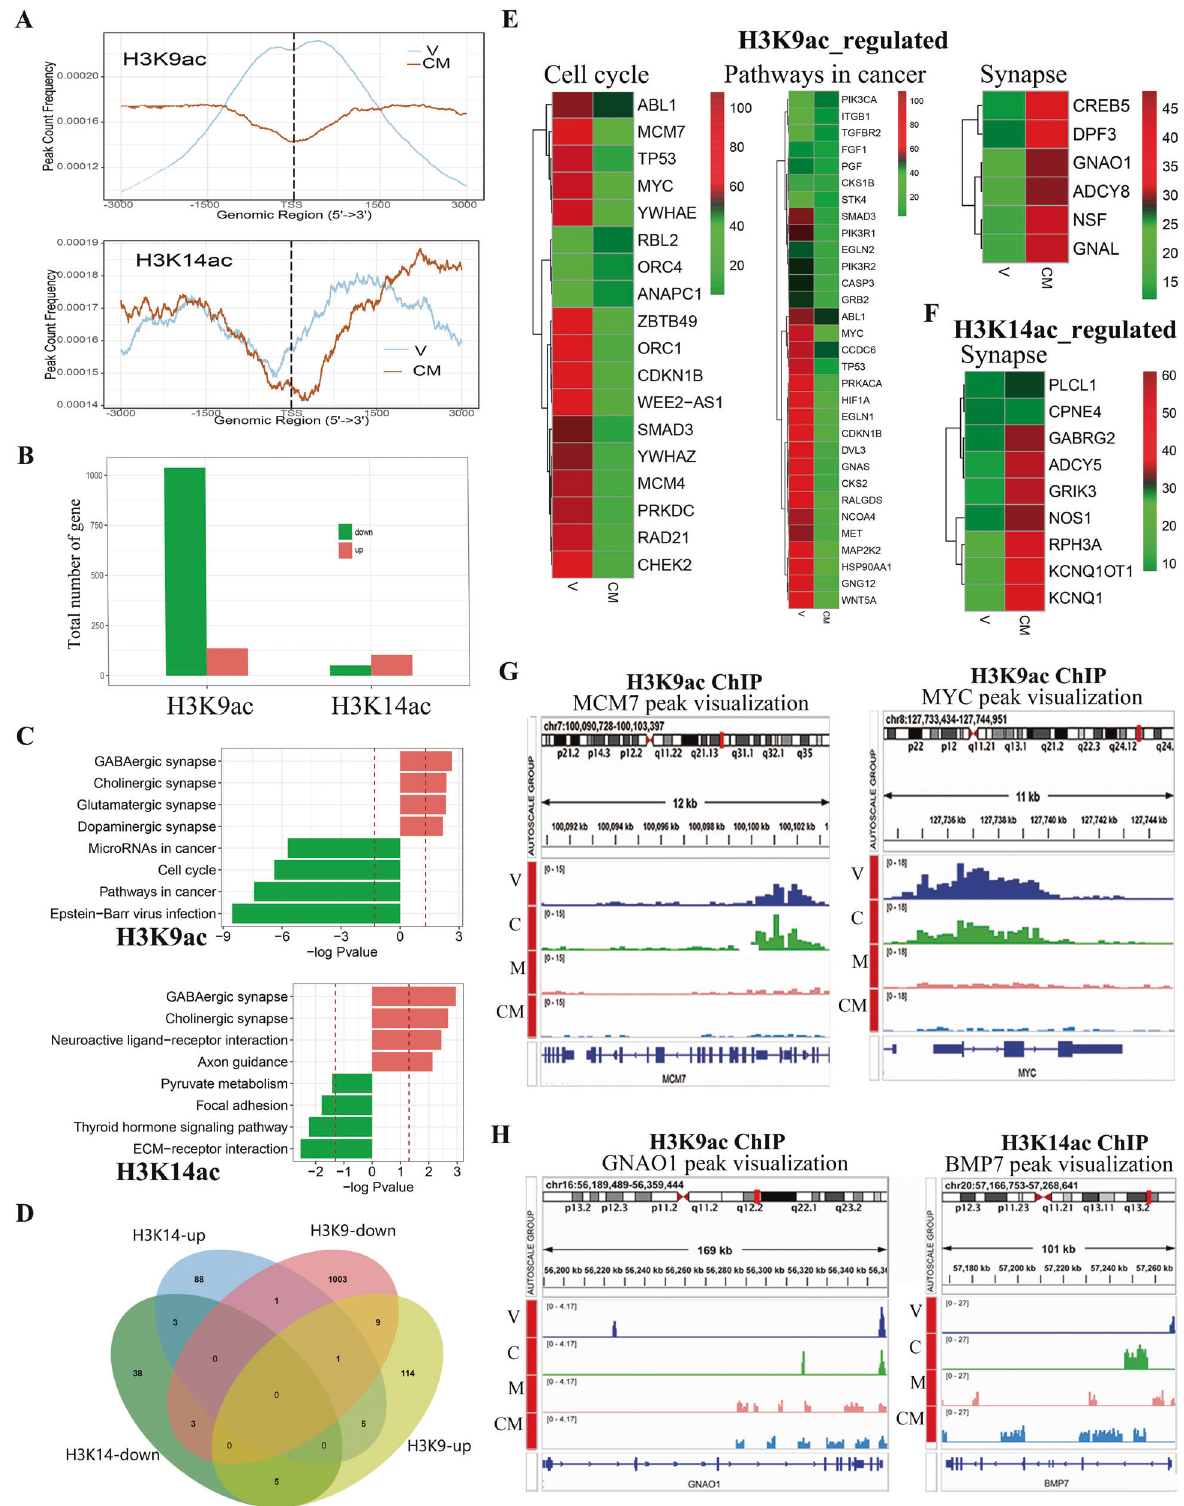
Fig. 4 ChIP-seq analysis shows the effect of CM on H3K9ac/H3K14ac-marked genes. A Average pro fi le of H3K9ac/H3K14ac peaks binding to TSS region in U87MG cells treated with V or CM for 2 days. B Dysregulated genes with H3K9ac/H3K14ac tags identi fi ed by ChIP-seq. C Gene enrichment analysis of genes with altered H3K9ac/H3K14ac tags. Red trace lines indicate adjusted P = 0.05. D Venn diagrams showing gene counts regulated by H3K9ac and/or H3K14ac. E , F Heatmap of genes with altered H3K9ac/H3K14ac tags. G , H Representative peak plot of oncogenes regulated by H3K9ac (MCM1 and MYC). H Representative peak plot of neuron development-related genes regulated by H3K9ac/ H3K14ac (GNAQ1 and BMP7). V, Vehicle (1 ‰ DMSO); C, 0.5 mM 8-CPT-cAMP; M, 1 μ M MS275.